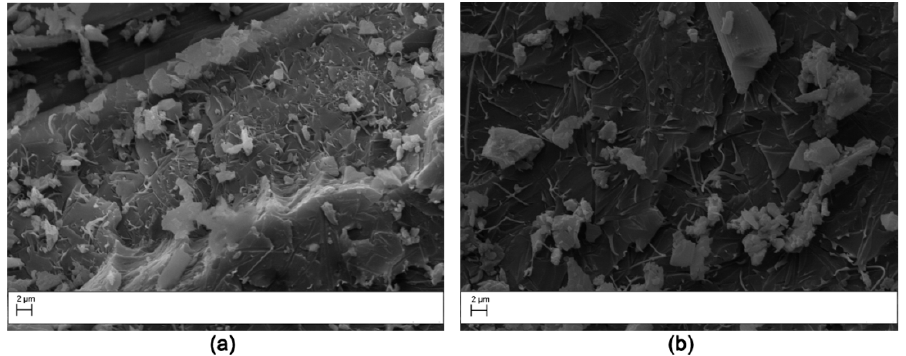
Figure 11. SEM of the fracture surface for the V0 double cantilever bending (DCB) sample: low magnification (50 × ) ( a ); high magnification (200 × ) ( b ).